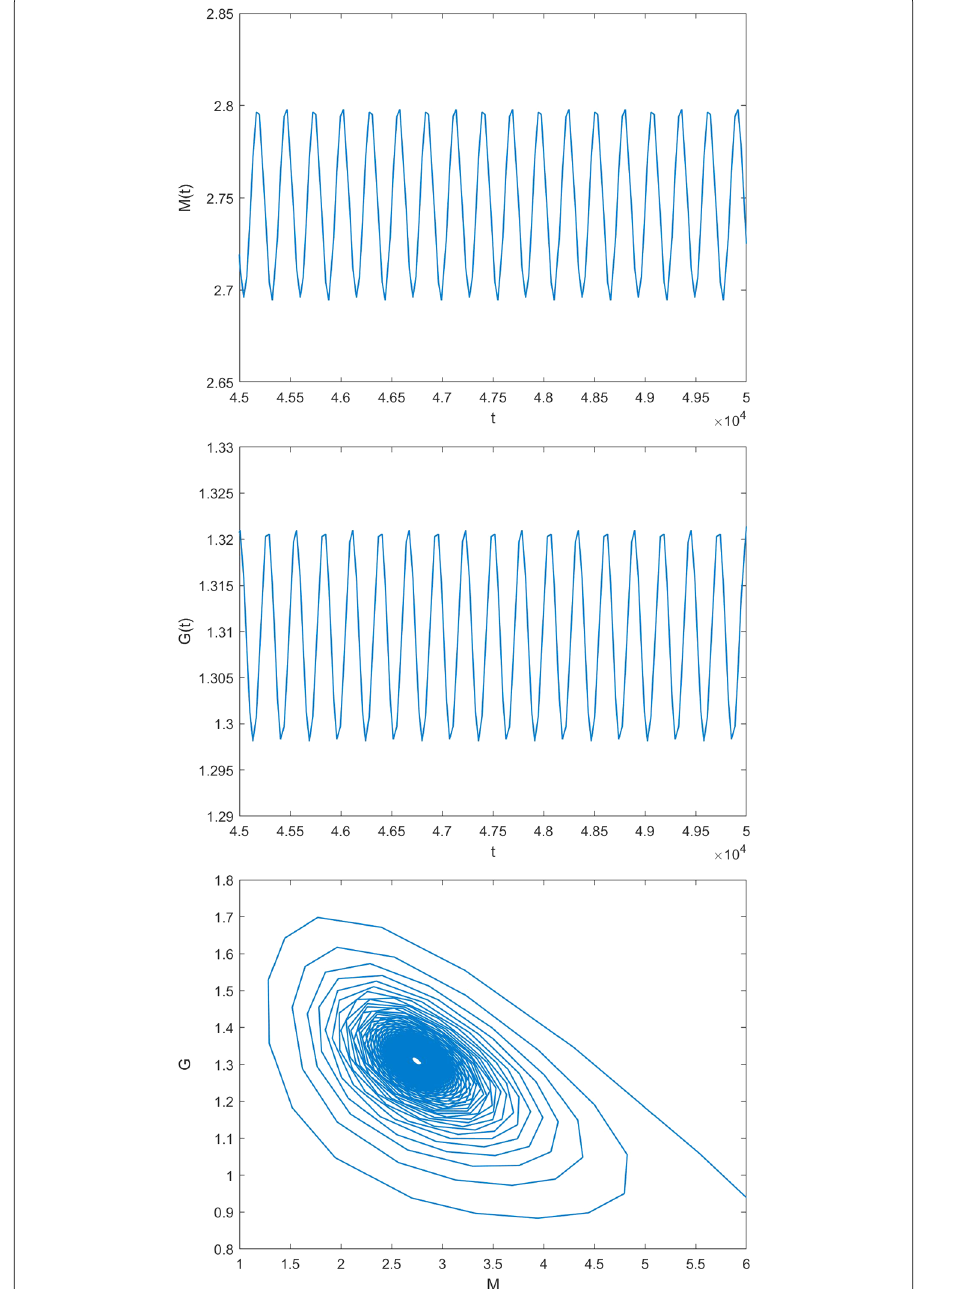
Figure 5 A computer simulation of the system (2.1)–(2.2) with a 1 = 0.1450, a 2 = 0.6937, b 1 = 0.0596, b 2 = 0.0206, α 1 = 0.16385, k 1 = 15.64, k 2 = 12.4113, τ = 30 > τ 0 = 22.5131, where M (0) = 5 and G (0) = 0.1, for which all conditions in Theorem 4 are satisfied. The solution trajectory exhibits periodic behavior as theoretically predicted